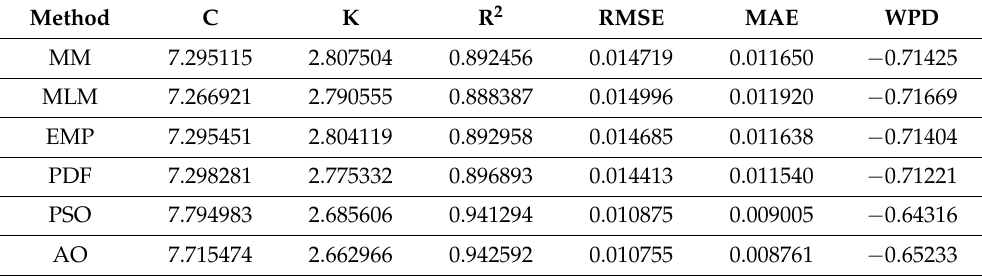
Table 4. Statistical analysis: Shark El-Ouinate site,